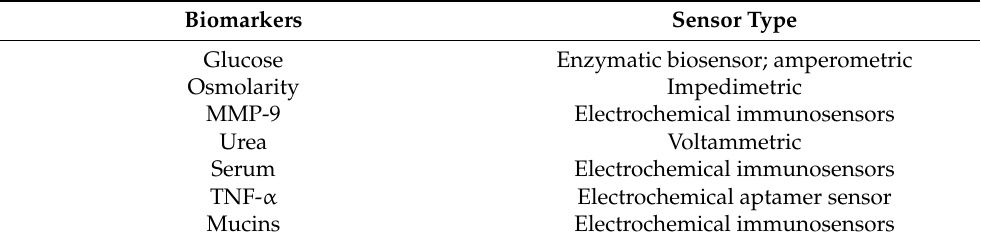
Figure 9. Sensing capability of contact lens sensors. Reprinted with permission from reference [24]. Copyright 2021 John Wiley and Sons. Table 7. Electrochemical sensors that can sense vital biomarkers of DED in tears. Adapted from reference [24]. Copyright John Wiley and Sons.